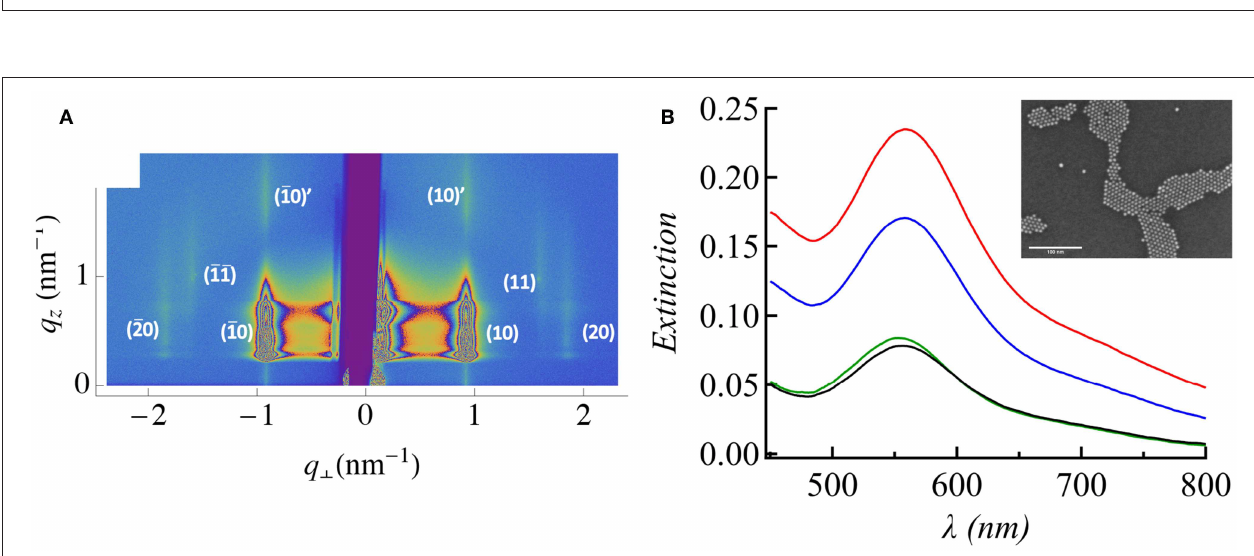
FIGURE 2 | (A) GISAXS signal of the NPs without LC, revealing the rods associated with the NP hexagonal network. (B) Light extinction of a network of NPs deposited on rubbed PVA substrate without LC. The LSP intensity varies depending on the measured area but not the wavelength resonance value ( λ except for the smallest intensity associated with the smallest NP domains. This demonstrates that, for λ considered as infinite for the LSP properties. In inset is shown a Scanning Electron Microscopy (SEM) picture obtained with the same NPs when they were deposited on a Si substrate covered by rubbed PVA, also showing formation of an hexagonal network of NPs.